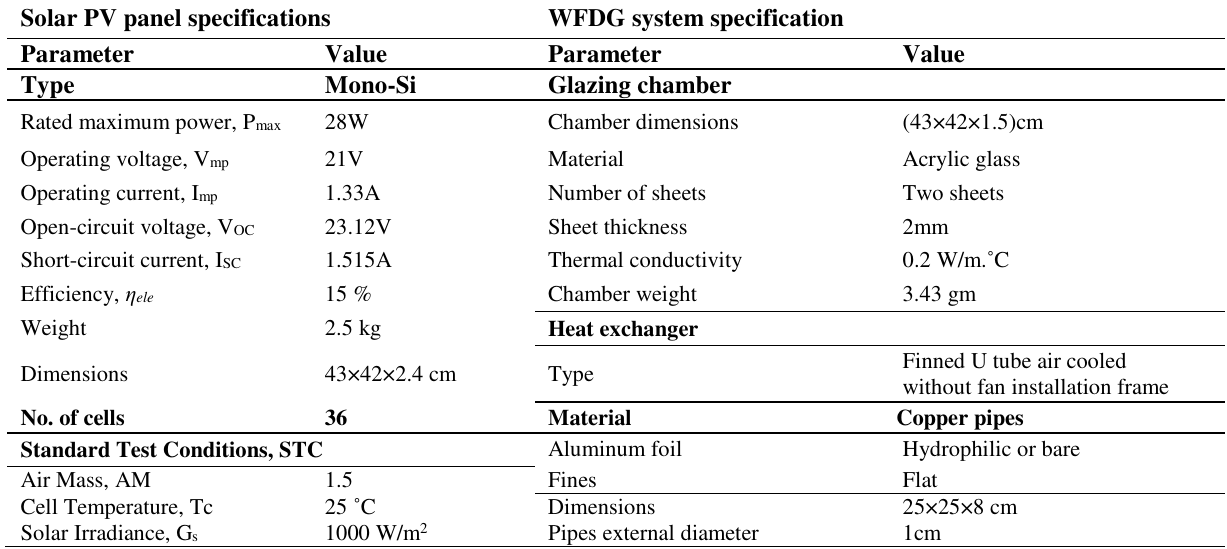
PV panel and WFDG system specifications.